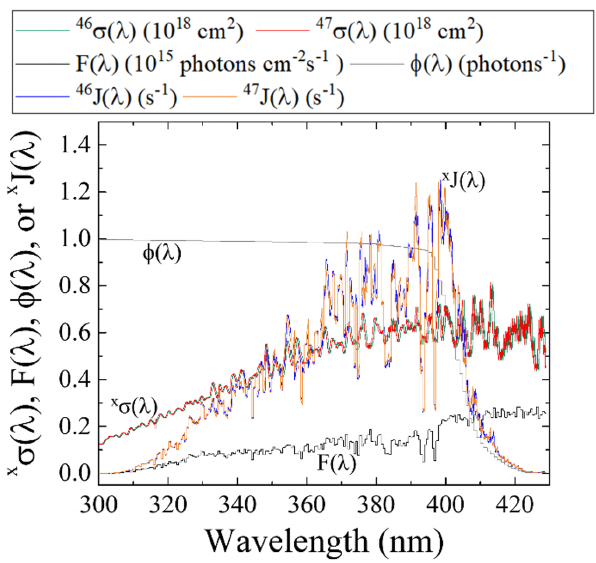
Figure 5. Literature-reported 46 σ(λ) (Vandaele et al., 2002) F(λ) (at SZA of 60 ◦ ; TUV model), and NO 2 φ(λ) (Roehl et al., 1994) and calculated 47 σ(λ) derived from the ZPE shift model for wave- lengths relevant for tropospheric conditions for NO 2 photolysis. From these parameters, both 46 J(λ) and 47 J(λ) have been calcu- lated (Eq.